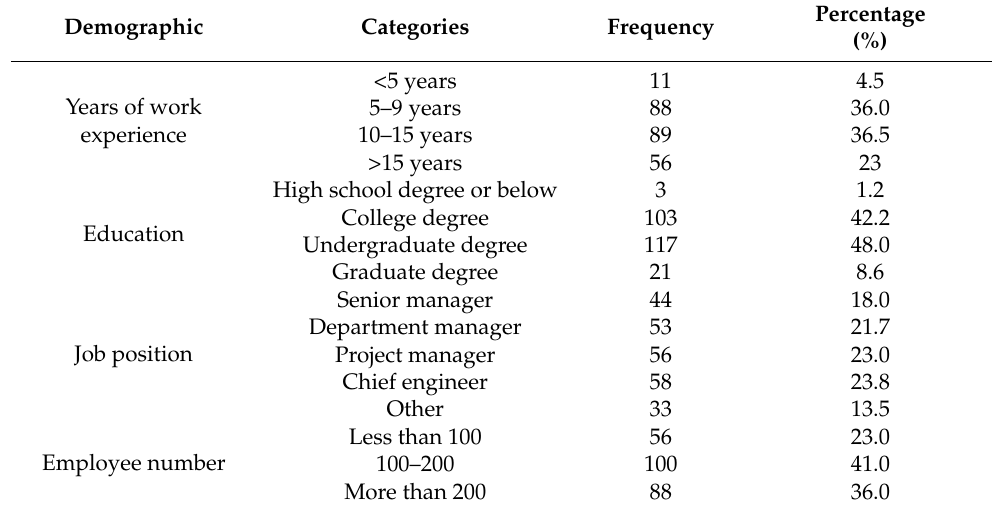
Table 1. Profiles of questionnaire